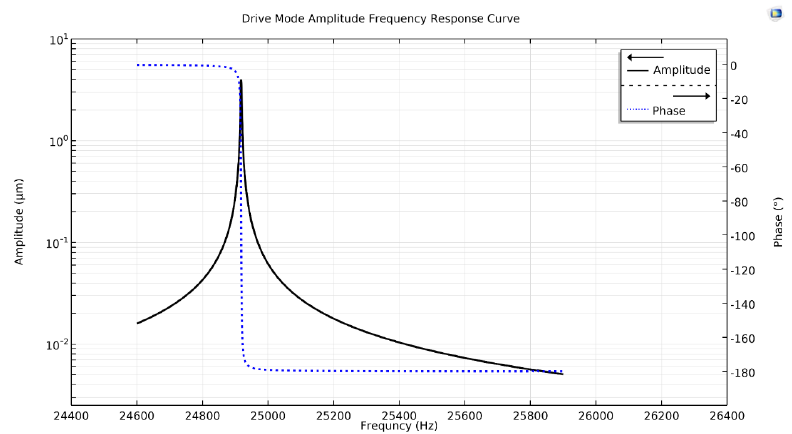
Figure 4. Drive-mode amplitude frequency response curve of the proposed single-drive, 3-axis MEMS